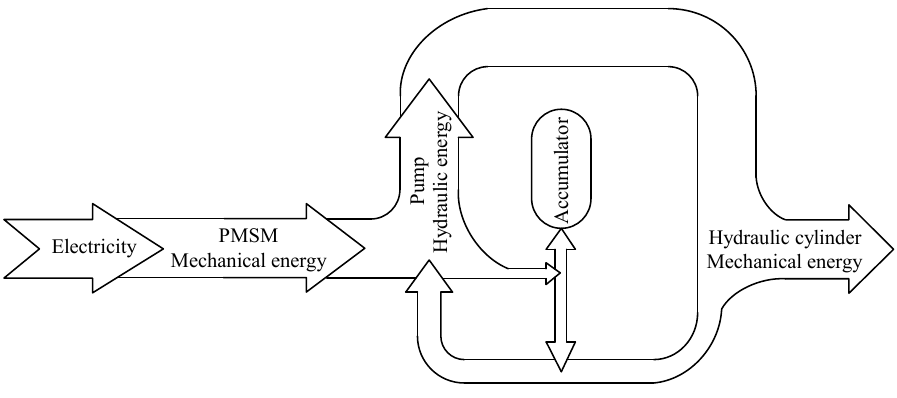
Figure 2. Schematic diagram of the EHSPCS energy flow.